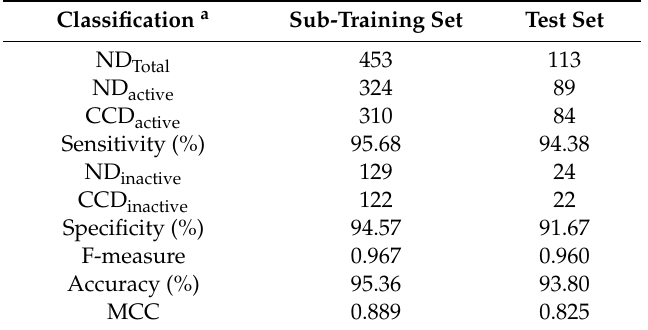
Table 1. Overall performance of the final multitarget-quantitative structure–activity relationship (mt-QSAR) linear discriminant analysis (LDA)